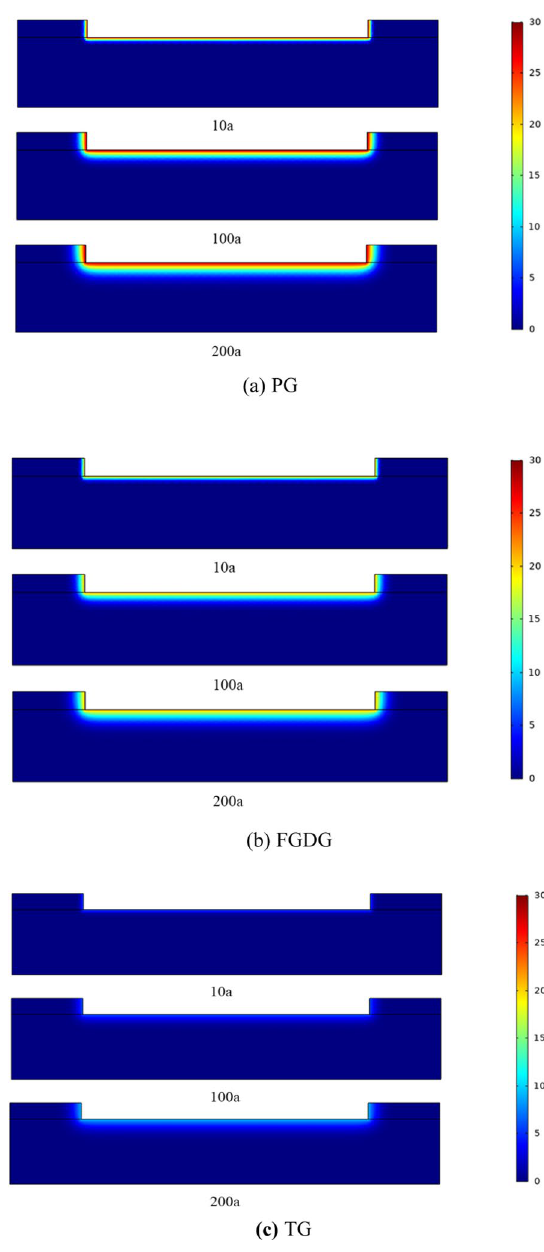
Fig. 5 Cloud maps of the Zn concentration distributions at 10a, 100a and 200a (10 −5